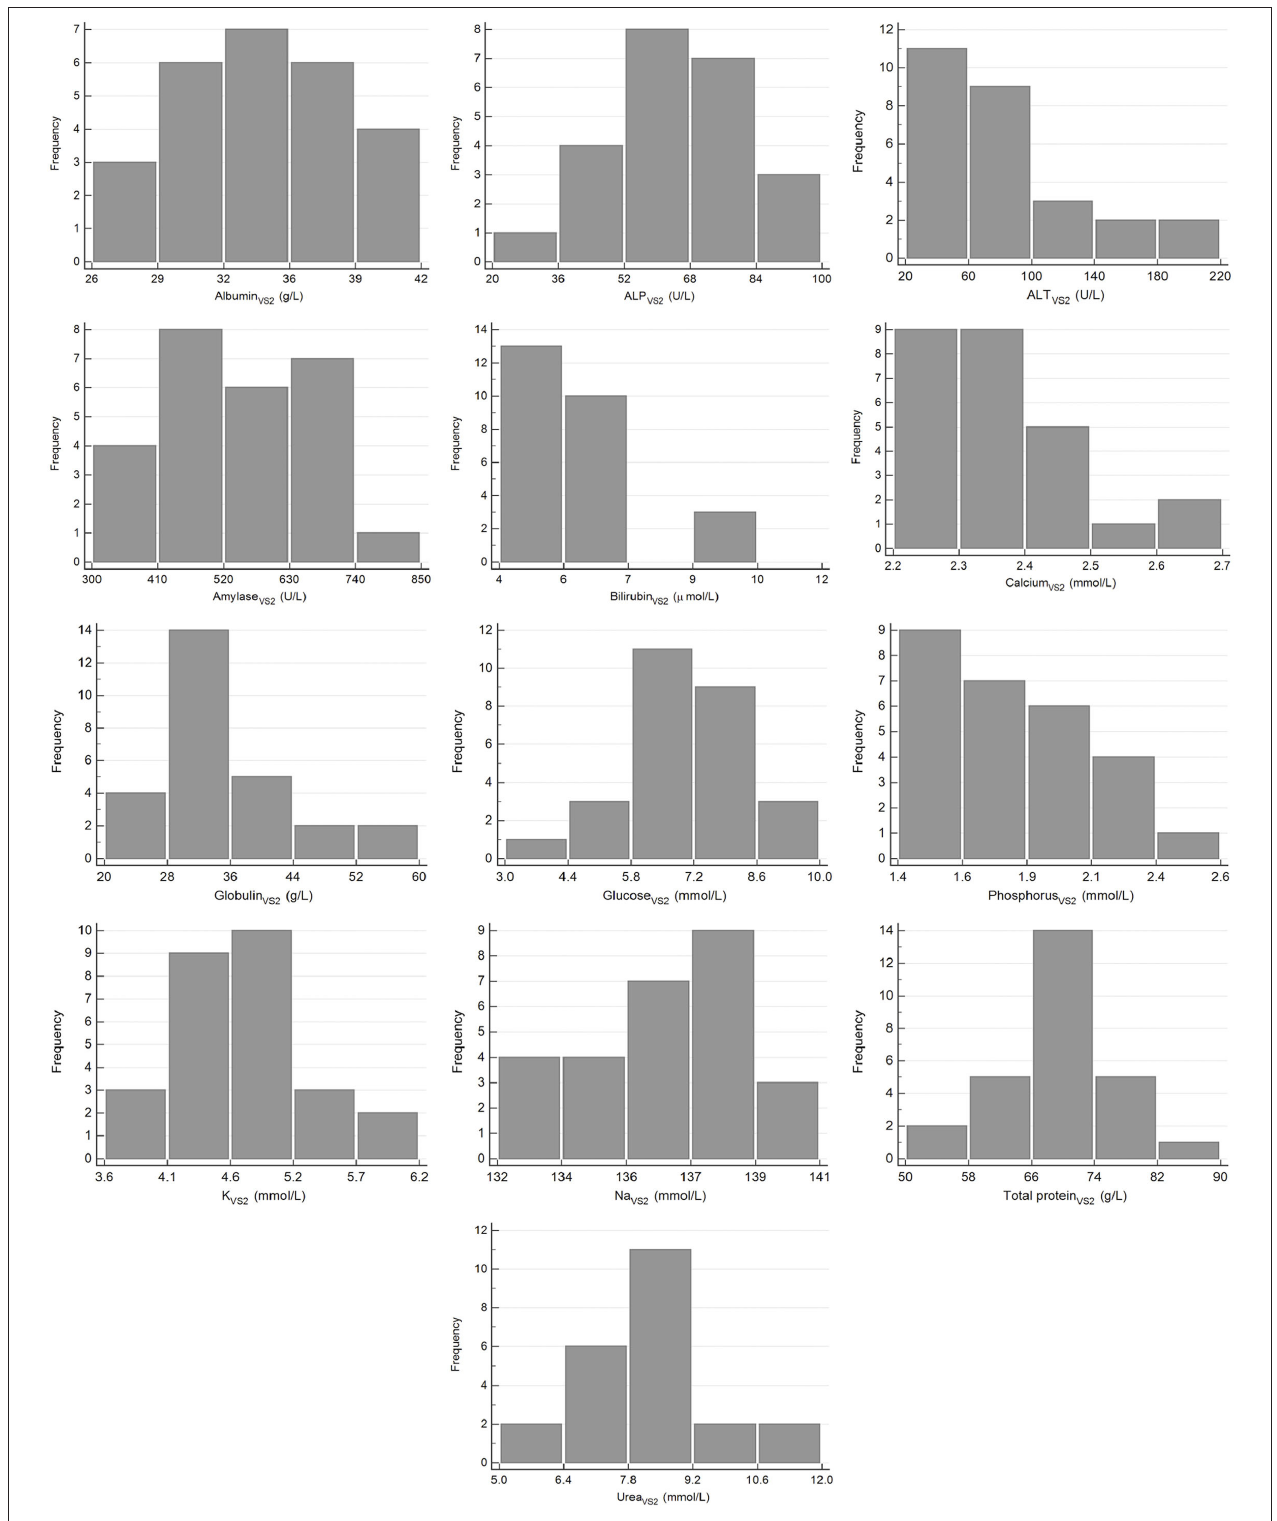
FIGURE 4 | Histograms showing the distribution of results for plasma clinical chemistry measurands from Temminck’s pangolin for the Abaxis Vetscan VS2. The x-axis represents the measurand result; the y-axis represents the frequency of these values occurring.